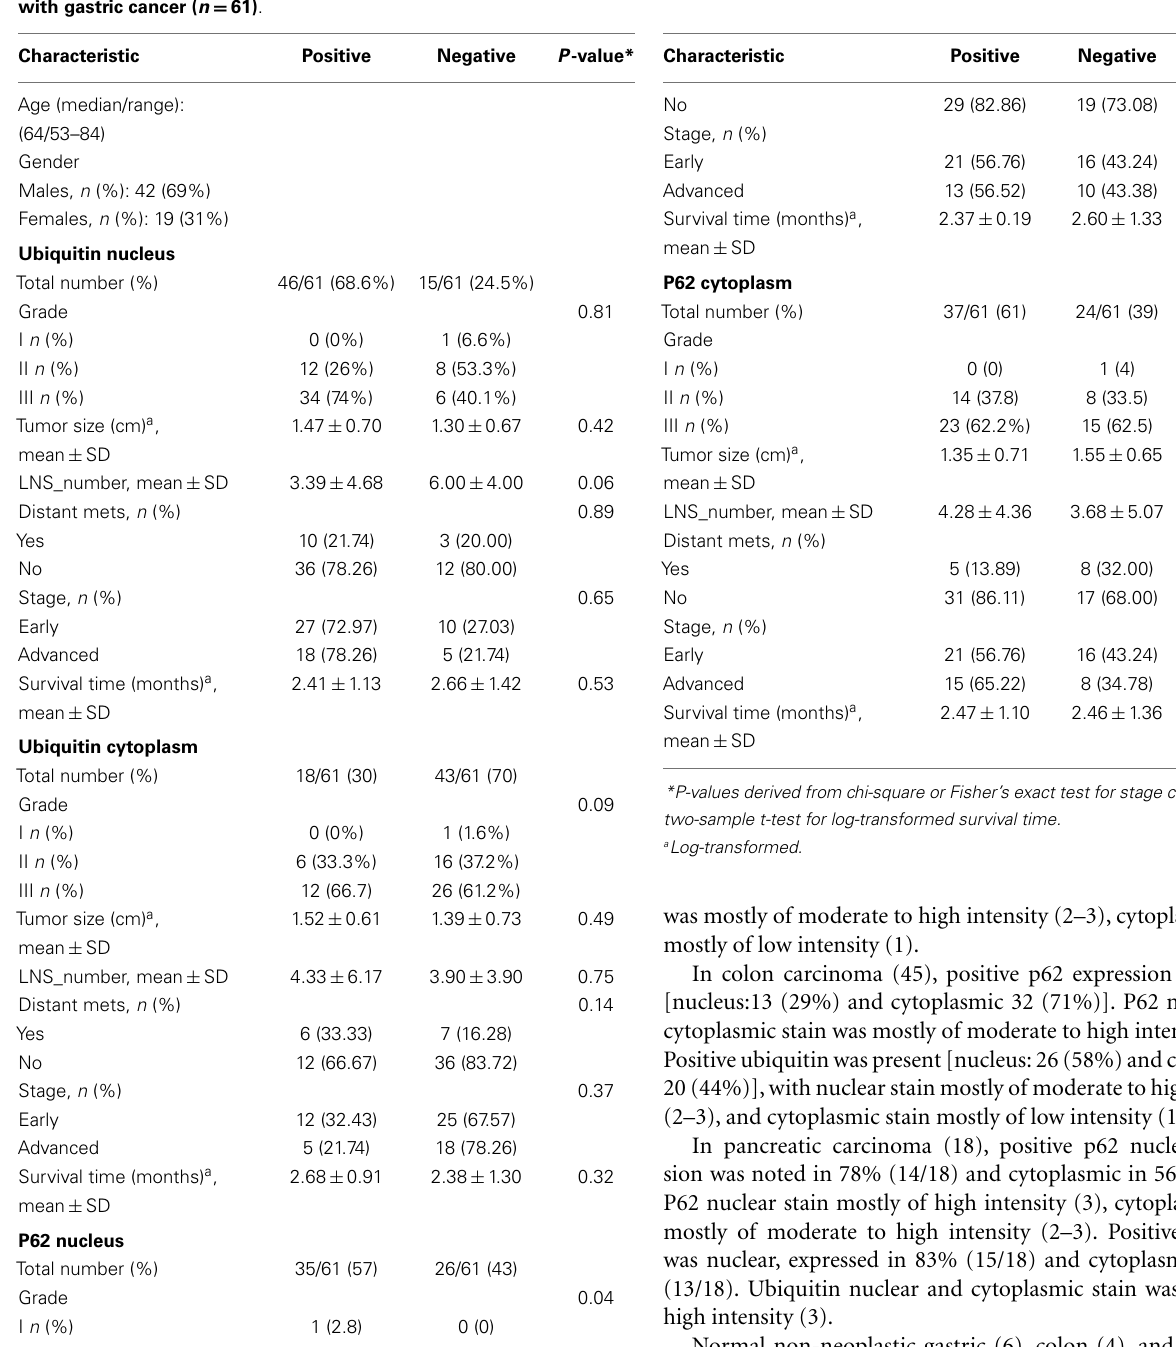
Table 1 |Analysis of tumor variables and overall survival in patients with gastric cancer ( n = 61)